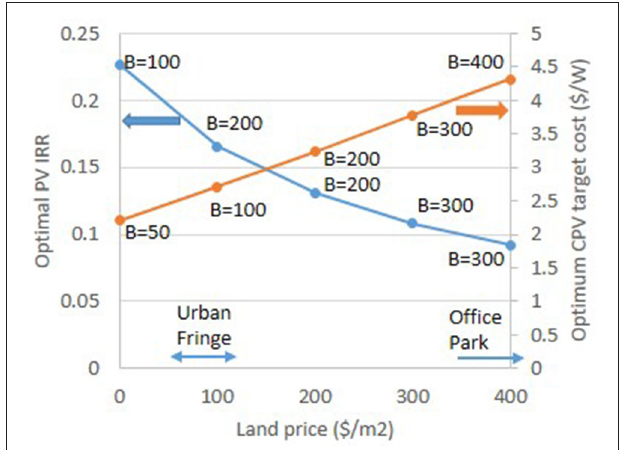
FIGURE 9 | Results of choosing optimal battery capacities at different land prices in Lancaster with the 8a.m. 6 p.m. load profile, (i) for PV IRR (left axis, − blue graph) and (ii) for the CPV target cost that matches the PV IRR (right axis, orange graph). The battery capacities that achieve these optima are indicated by each point on the two graphs.